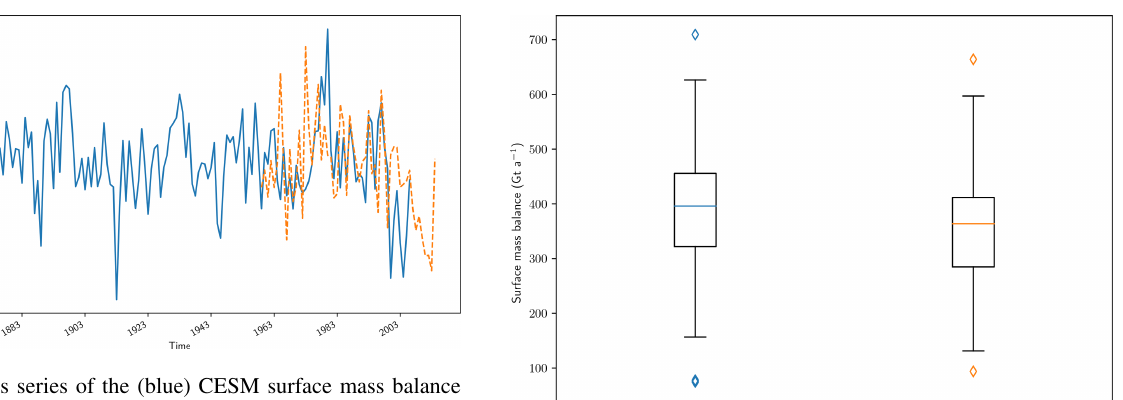
Figure 9. Times series of the (blue) CESM surface mass balance for the entire simulation, 1851–2006, compared to the (orange) RACMO 2.3 surface mass balance.